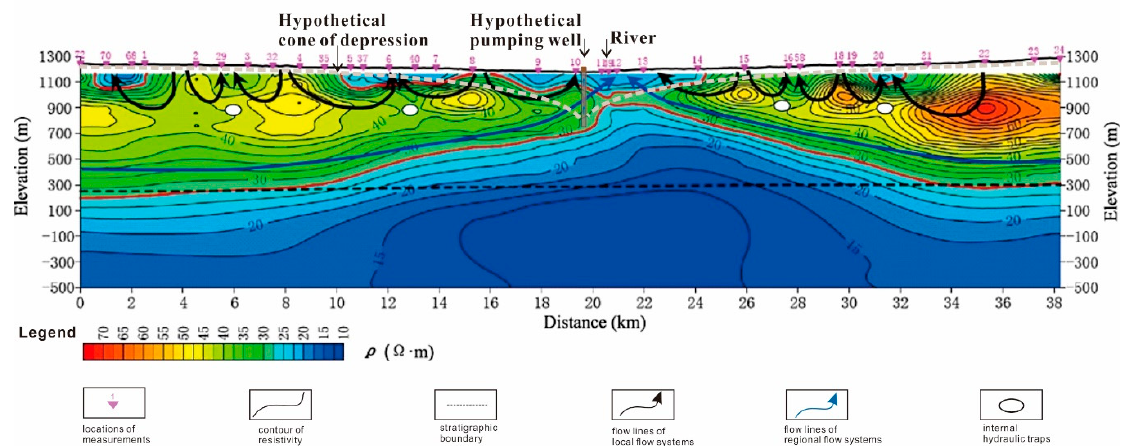
Figure 5. Schematic flow lines of a practical site according to the distribution of apparent resistivity, with a hypothetical pumping well added (modified from [27]).